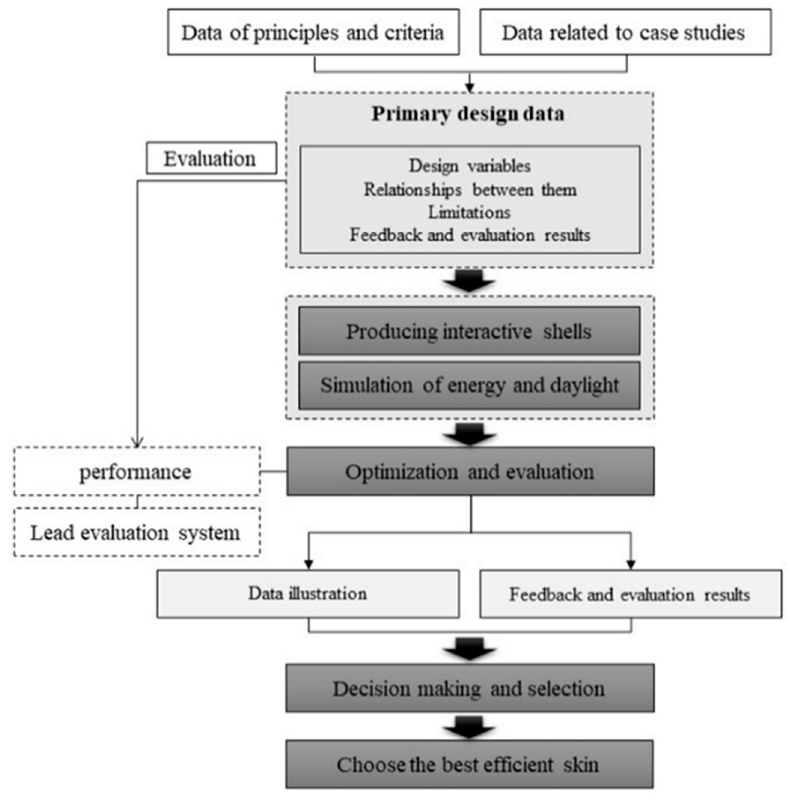
Figure 2. Research workflow.